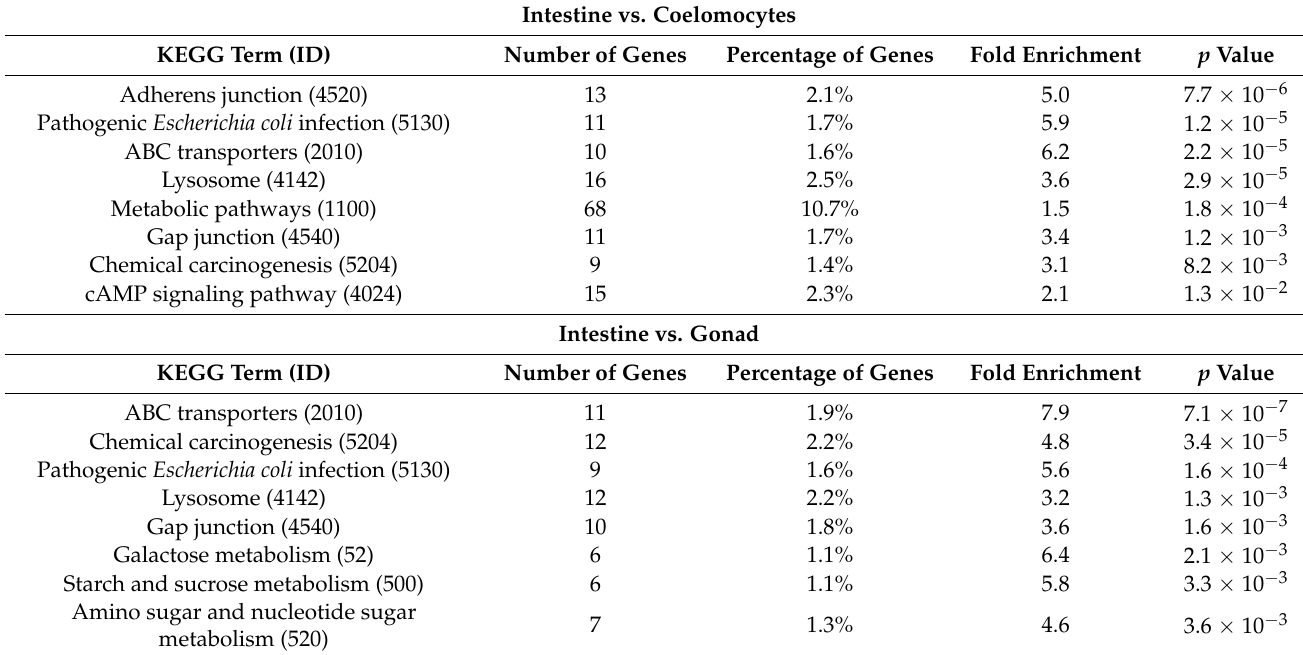
Table 4. The Top-16 KEGG pathways enrichment of up-regulated transcripts of intestine in the edible red sea urchin ( L. albus ). In comparison to coelomocytes, adherens junction was the most overrepresented and ABC transporters compared to